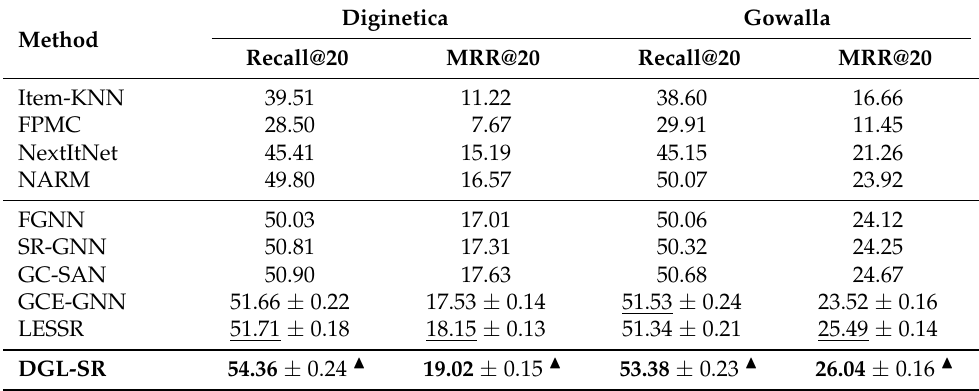
Table 3. Model performance. The results of the best-performing baseline and the best performer (cid:78) in each column are underlined and boldfaced, respectively. denotes a significant improvement of DGL-SR over the best baseline using a paired t -test ( p < 0.01). Moreover, we add the standard deviations of five runs for the performance of the state-of-the-art baselines, that is, GCE-GNN and LESSR, as well as our DGL-SR to make the results more